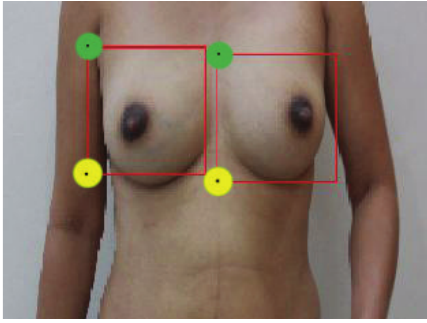
Figure 6: The detected breasts with starting and ending points.